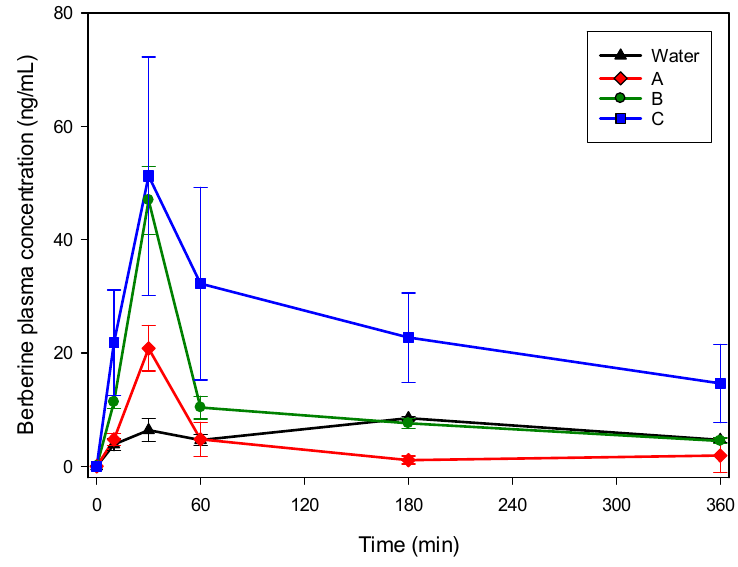
Figure 2. Time course (mean ± SD) of plasma concentration of berberine in Balb/c mice following oral administration of 50 mg/kg in NADES solution or suspension in water. Table 4. Non-compartmental pharmacokinetic parameters of berberine following oral administration in Balb/c mice.